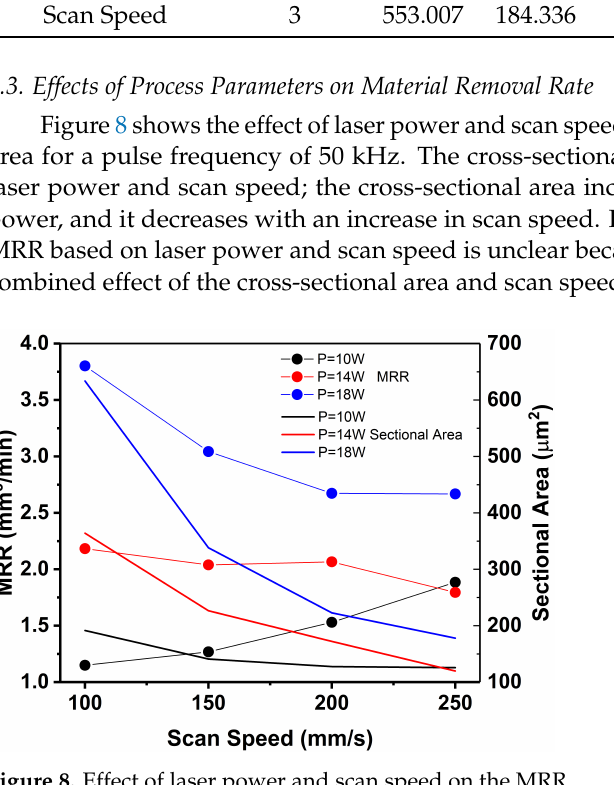
Figure 8. Effect of laser power and scan speed on the